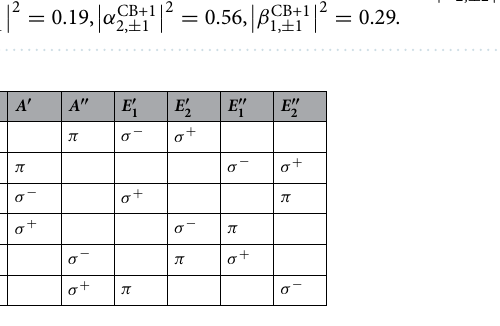
Figure 6. The optical selection rules in pristine SL WS 2 satisfy the equation (cid:31) m 0 3 for π transitions. The term and (cid:31) m = ± selection rules corroborate the difference between the in-plane and out-of-plane band gaps E g respectively. The Bloch states at the K and K’ points transform according to the IRs of the C 3 h point group. The coefficients of the main contributions are given by (cid:31)